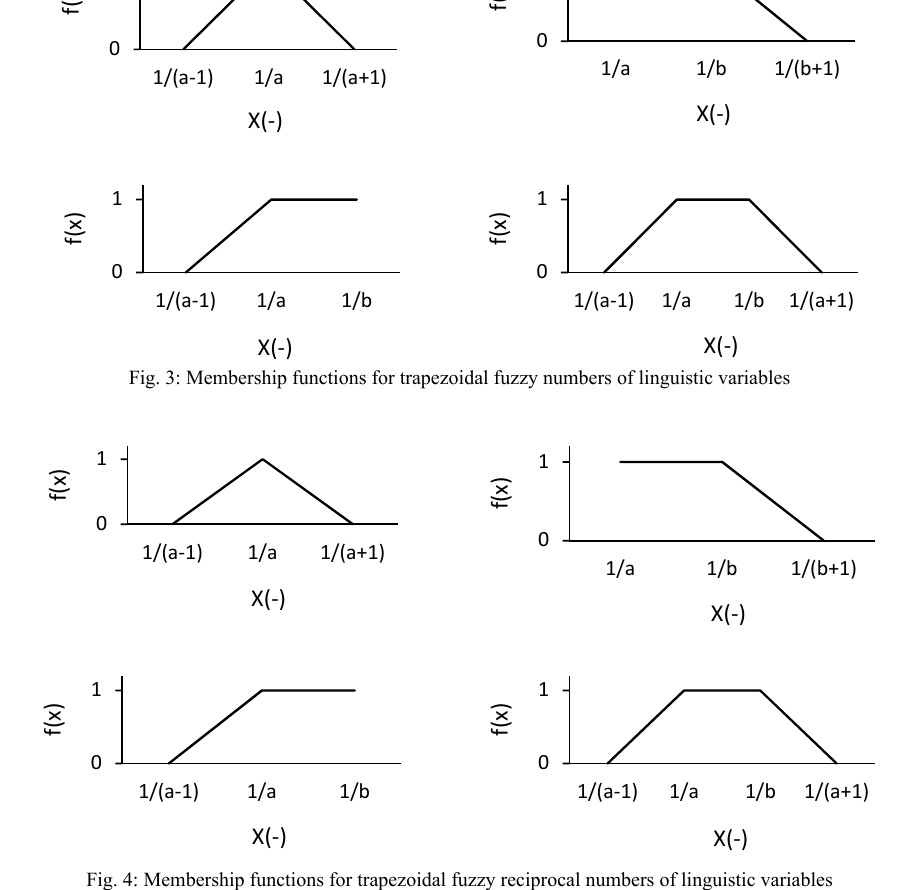
Fig. 4: Membership functions for trapezoidal fuzzy reciprocal numbers of linguistic variables